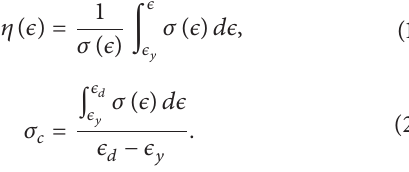
Table 2. The compression test of the expanded polystyrene foam is taken from Chen et al. [15].